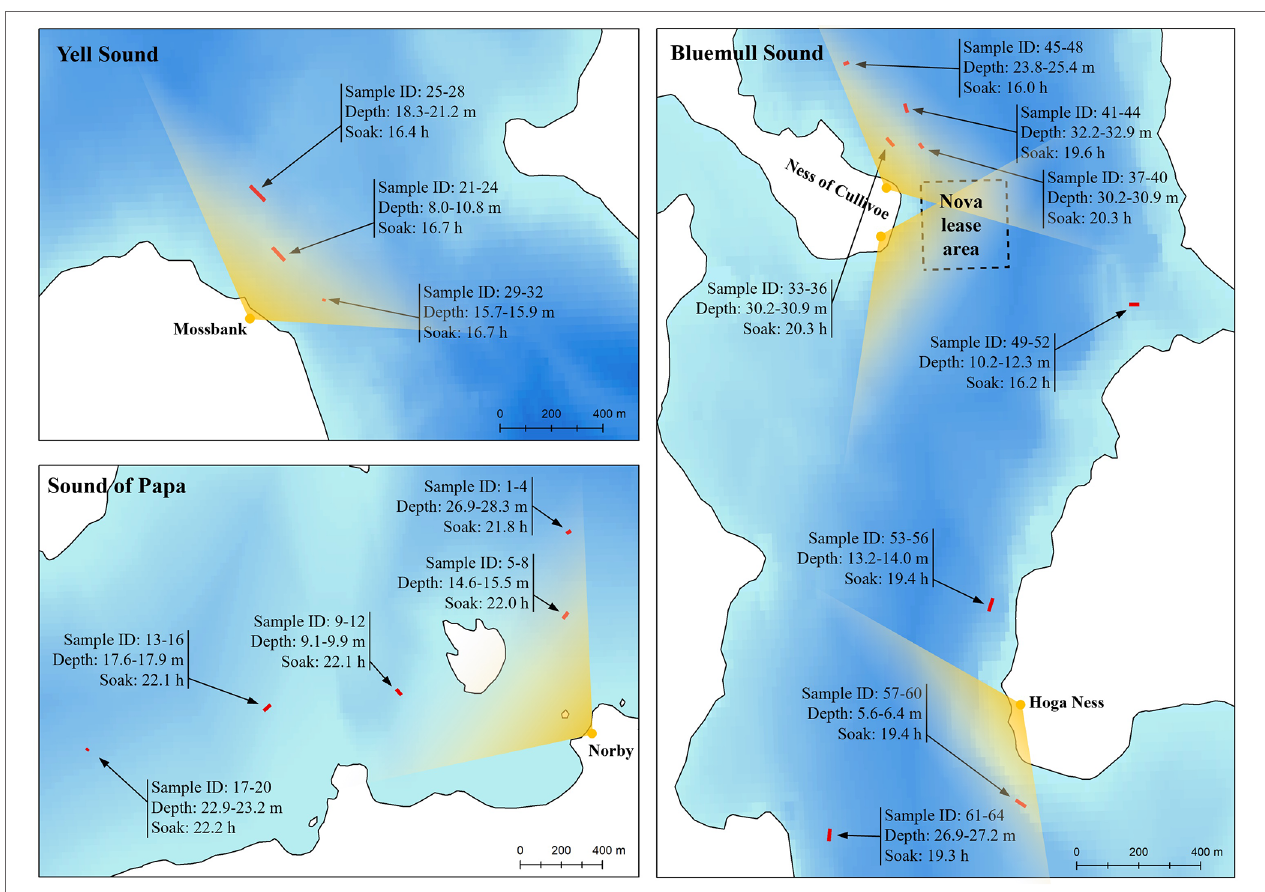
FIGURE 3 | Site maps showing overall data collection strategy in the three tidal channel environments considered here: Bluemull Sound, Yell Sound, and the Sound of Papa. Vantage point locations are shown in yellow with an approximate field-of-view arc represented in each case. Fish trap string locations are shown in red with each string comprising four traps (two seabed and two floating traps) given sample IDs. The range of trap depths observed during deployment for each string is shown, along with soak time. The location of the Shetland Tidal Array is represented by the Nova lease area boundary coordinates at Bluemull